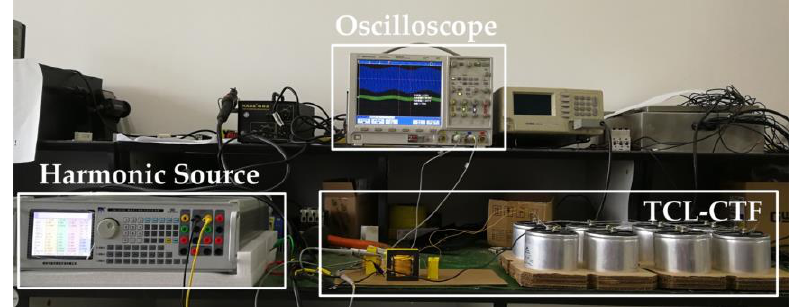
17 of 23 . Figure 13. Waveforms and fast Fourier transform (FFT) spectrum of i L and i sys . 6.2.2. Experimental Results To test the actual filtering characteristic of the TCL-CTF, an experimental prototype of the